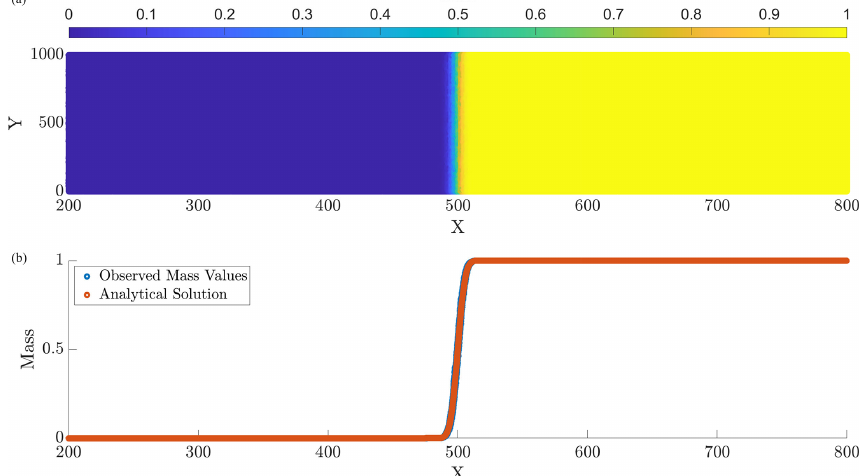
for each i,j = 1 ,...,N and normalize the mass-transfer (MT) kernel to ensure conservation of mass (Sole-Mari et